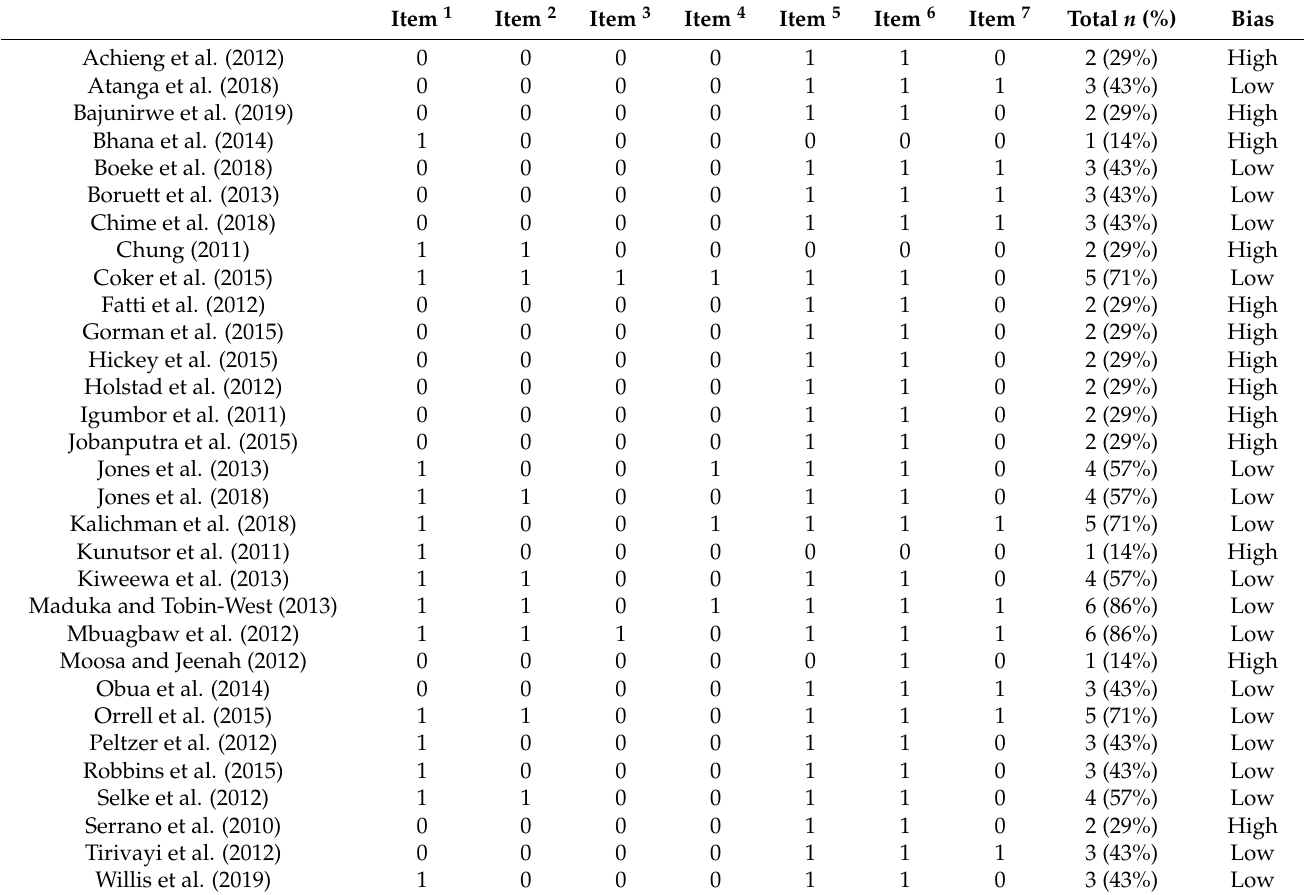
Table 3. Risk of bias ratings for each study